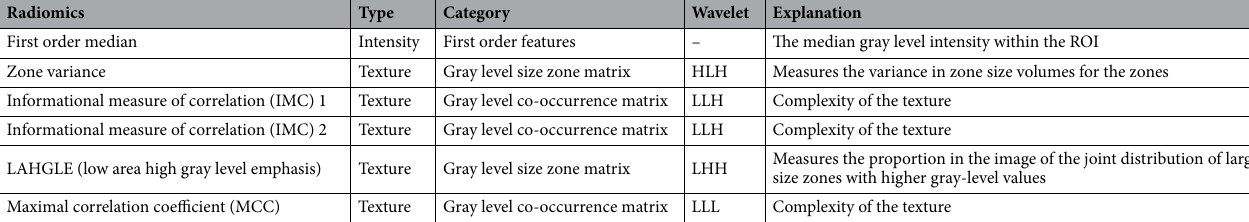
Table 2. Significance of the top radiomic features included in the final